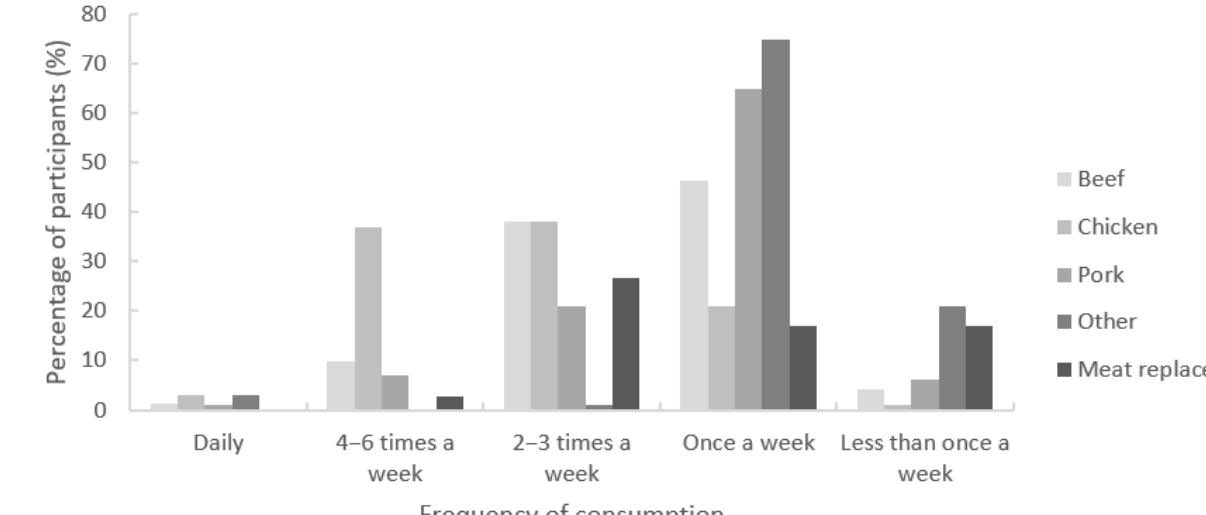
Figure 3. Frequency of meat and meat replacer (from left to right: beef, chicken, pork, other meats, meat replacers) consumption by the members of the sensory panel at the main meal of the day/dinner per type of meat ( n = 71).